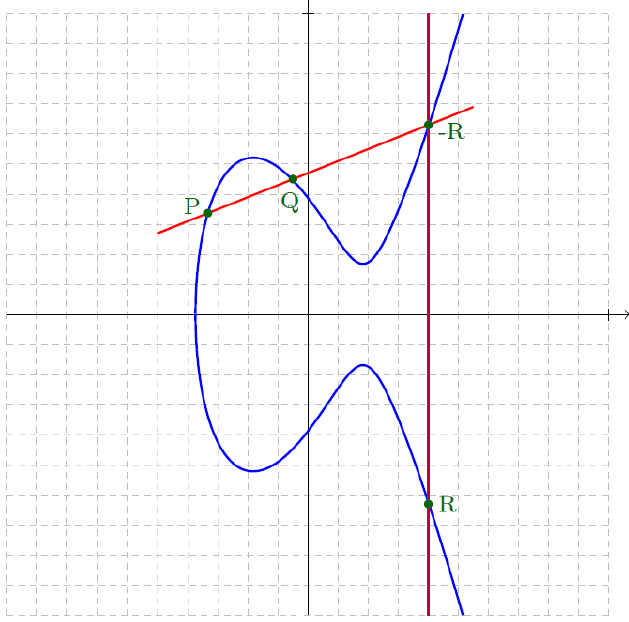
Figure 1. Point addition on an elliptic curve defined over the field R